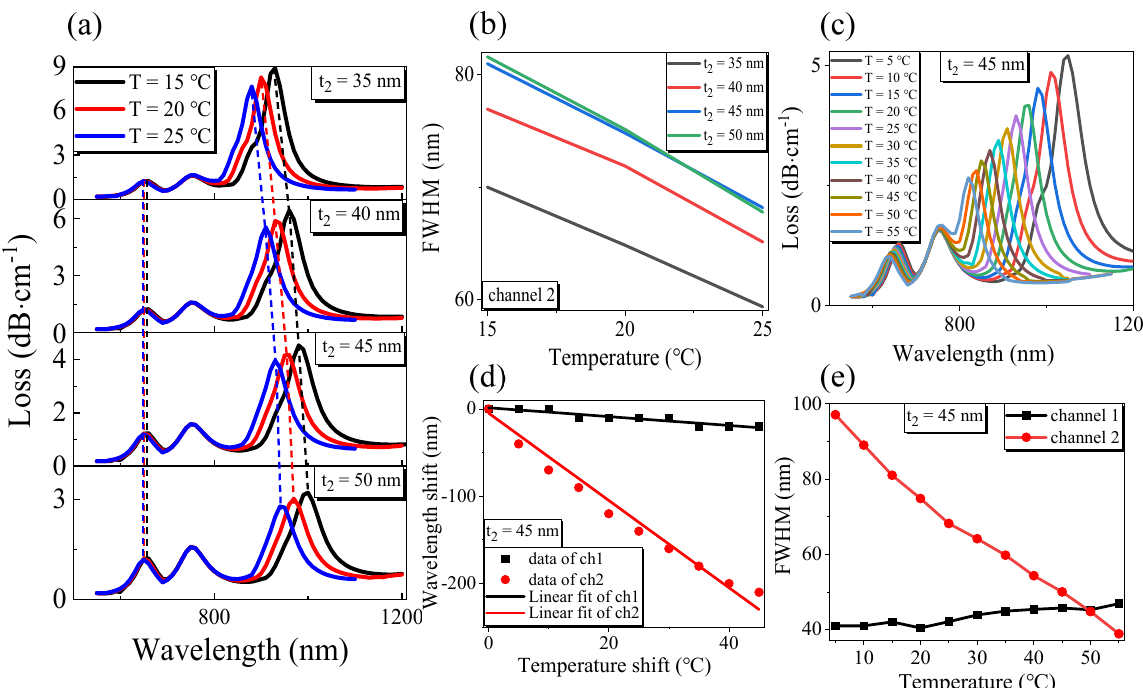
Figure 7. Optimization of metal film thickness t 2 structure of plasmonic optical fiber sensor under the same refractive index of H and liquid to be measured: ( a ) The variation of transmission loss with wavelength; ( b ) The FWHM of channel 1 and channel 2 varies with T under the different thickness of t 2 ; ( c ) The variation of transmission loss with wavelength at different T for t 2 = 45 nm; ( d ) The variation of resonant wavelength shift of channel 1 and channel 2 with T and its linear fitting results; ( e ) The FWHM of channel 1 and channel 2 varies with the intensity of T for t 2 = 45 nm.